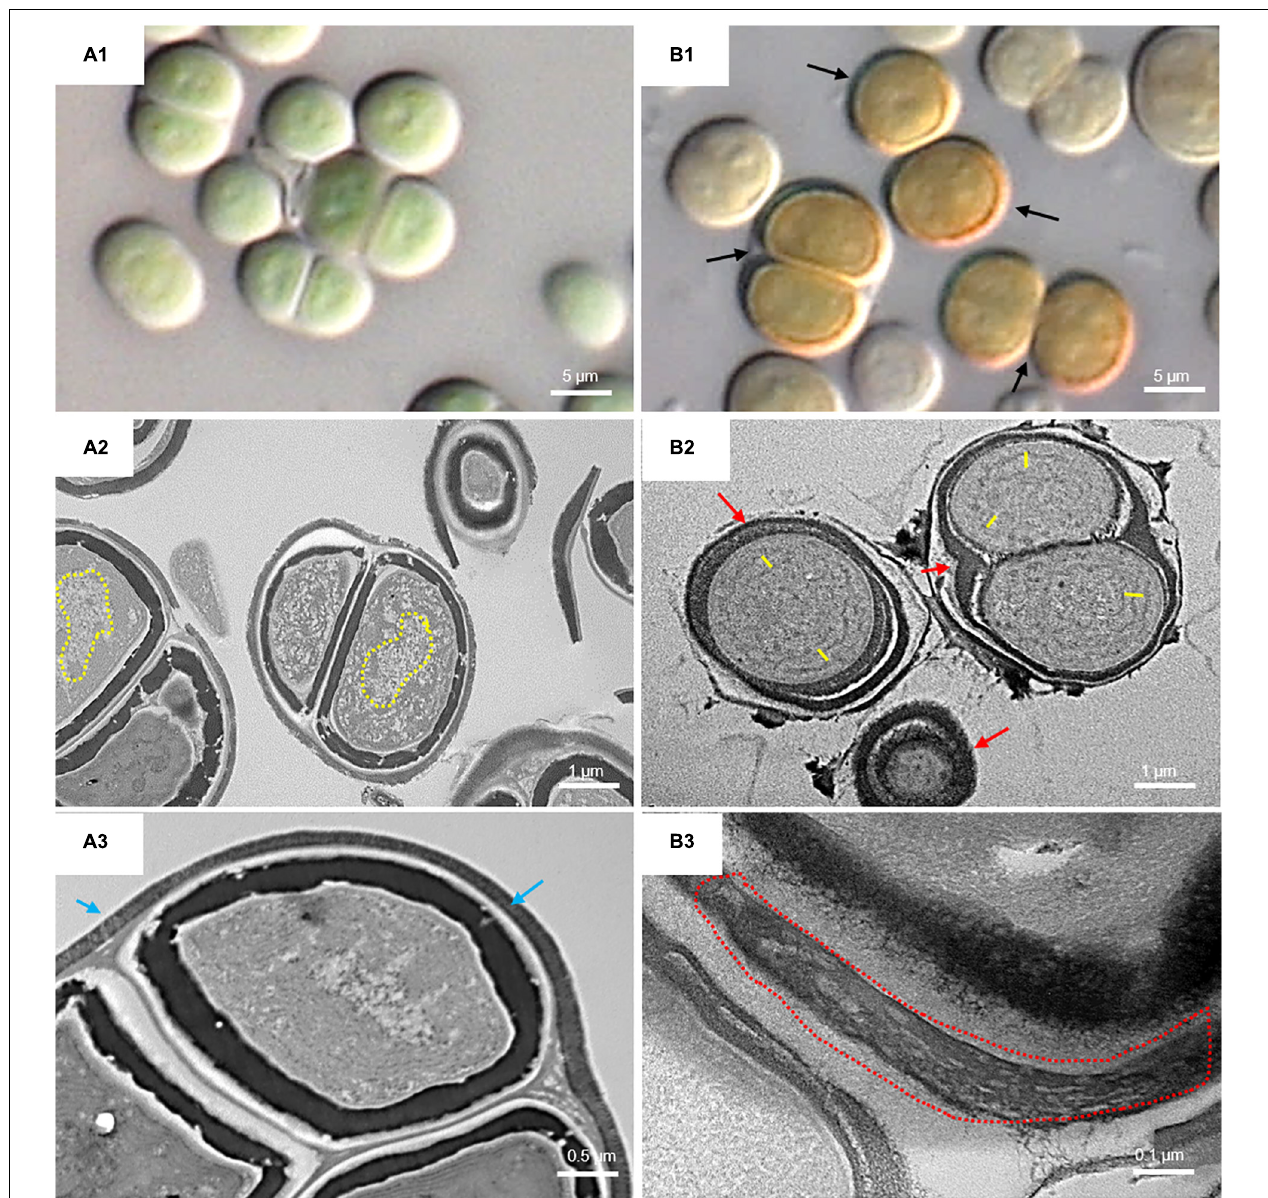
FIGURE 6 | DIC microscopy and TEM images of UAM813. Series A: Cells and aggregates at the beginning of the experiment. (A1) Green UAM813 cells. (A2) TEM image of cells with a visible nucleoid area (yellow dotted line). (A3) TEM image with a cell aggregate showing a thin, outermost fibrous layer (blue arrows). Series B: Cells and aggregates with maximum scytonemin content after 9 days of irradiation with UVR + PAR. (B1) Brownish UAM813 cells with higher scytonemin content at the edge. (B2) TEM image of cells showing separated thylakoids (yellow lines) and an electron dense outermost fibrous layer (red arrows). (B3) TEM image of the outer part of the cells from the same aggregate revealing a highly fibrous outermost layer (red dotted